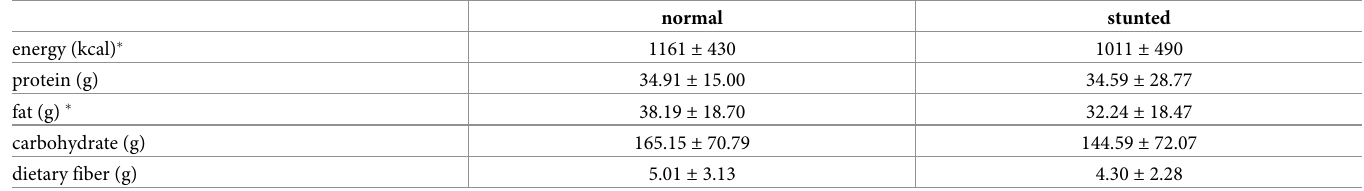
Table 3. Average ( ± SD) of macronutrients, energy and dietary fibre